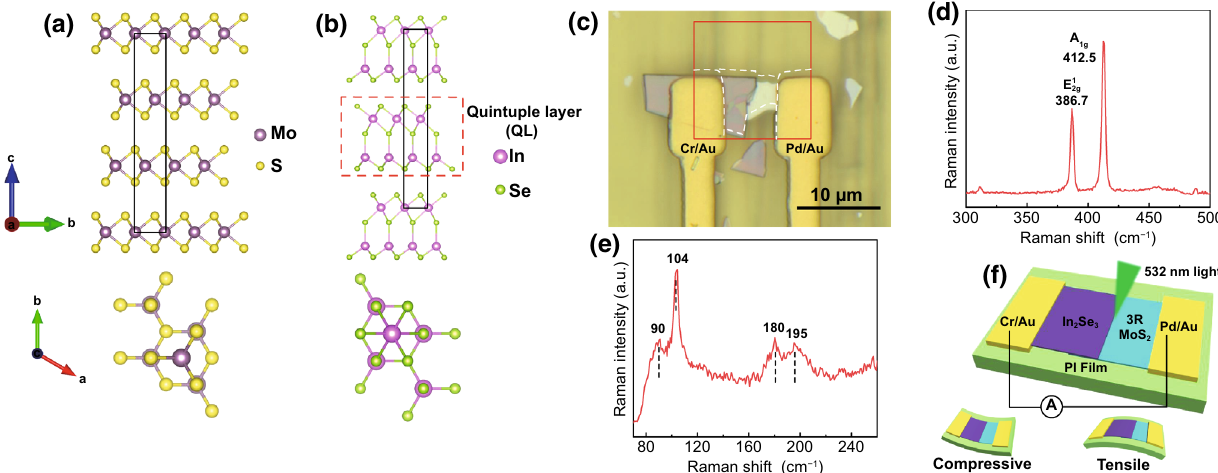
Fig. 1 Atomic structures of 3R phase MoS 2 and Hexagonal α-In 2 Se 3 , and optical, Raman spectra, electrical measurement setup of an α-In 2 Se 3 /3R MoS 2 heterojunction. a Side and top view of 3R MoS 2 atomic structure. The purple and yellow spheres correspond to molybdenum and sulfur atoms, respectively. b Side and top view of hexagonal α-In 2 Se 3 atomic structure. The pink and green spheres correspond to indium and selenide atoms, respectively. c Optical image of the heterojunction on a flexible substrate. d Raman spectrum of the 3R MoS 2 flake. e Raman spectrum of the α-In 2 Se 3 flake under the excitation of 532 nm wavelength laser. f Schematic diagram of the heterojunction on a flexible